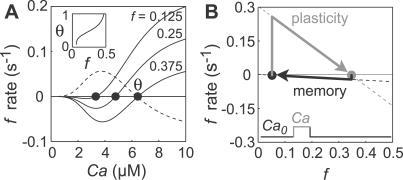
Plasticity and Memory as a Single Dynamic Process(A) f rate versus Ca in the deterministic model with standard parameters (solid lines) and KP = 6 μM, KK = 3 μM (dashed line). Inset: modification threshold θ versus f with standard parameters.(B) In the aKP cycle model, a saturating Ca pulse shifts the single steady state from f
∞(Ca
0) (black circle) to f
∞(Ca) (gray circle). f converges toward f
∞(Ca) at a high rate (gray solid trajectory) along the f rate function (gray dashed line). After the pulse, the new f value is memorized because f relaxes back toward f
∞(Ca
0) at a low rate (black solid trajectory) on the f rate function (black dashed line). The rate function at Ca
0 was multiplied by 106 for clarity as it otherwise nearly merges with the f-axis (thin line).